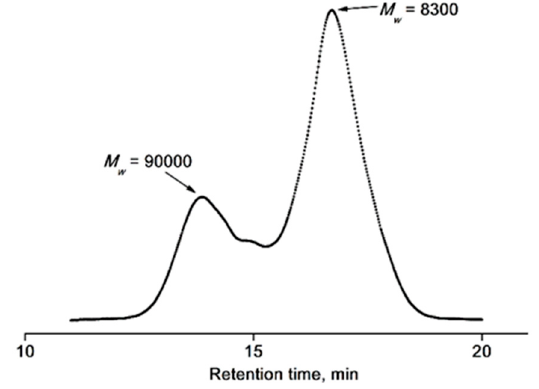
Figure 4. GPC trace for CL-PiPrOx in the DMF and LiBr system.